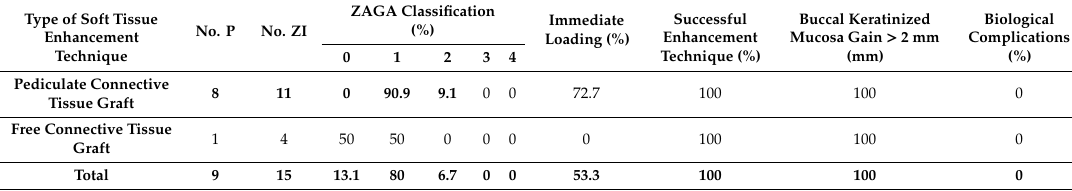
Table 4. Data referred to number of patients, number of zygomatic implants, ZAGA classification, immediate loading, successful enhancement technique, keratinized mucosa gain and biological complication at the implant level according to the type of soft tissue enhancement